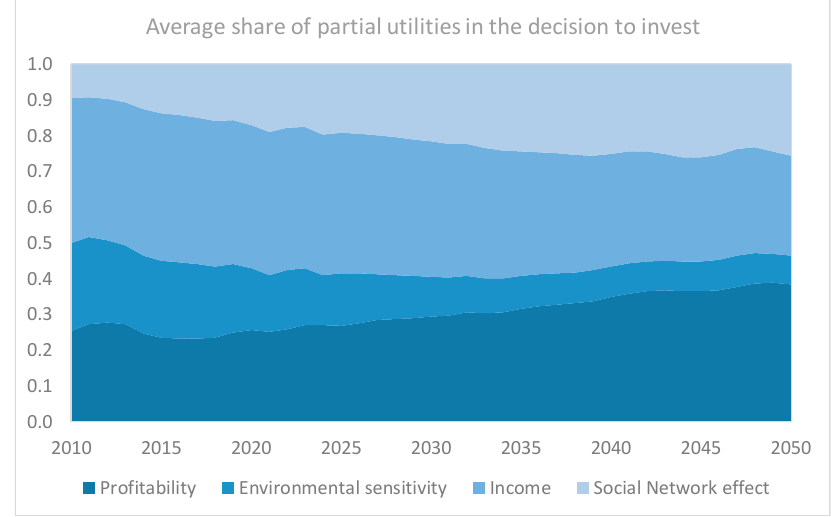
Figure 8. Share of the partial utilities in the total utility function of agents that invested in a solar PV system (average across all adopters).